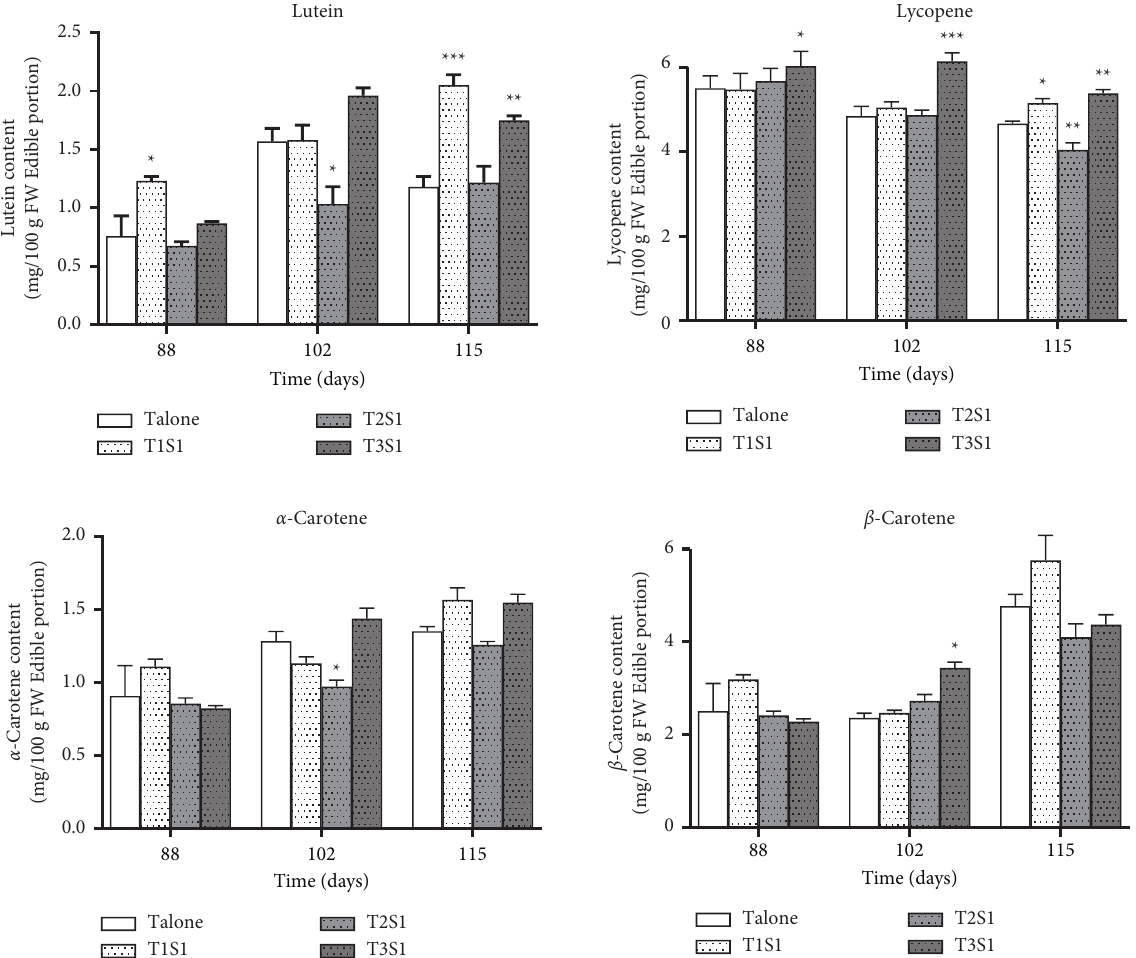
Figure 5: Effect of companion planting with sunflowers on carotenoid contents in tomatoes over time grown on the rooftop garden. Carotenoids were analyzed using an UPLC system (means ± SE, n � 3). Significantly different with the monoculture ∗ p < 0 . 05, ∗∗ p < 0 . 01, and ∗∗∗ p < 0 .